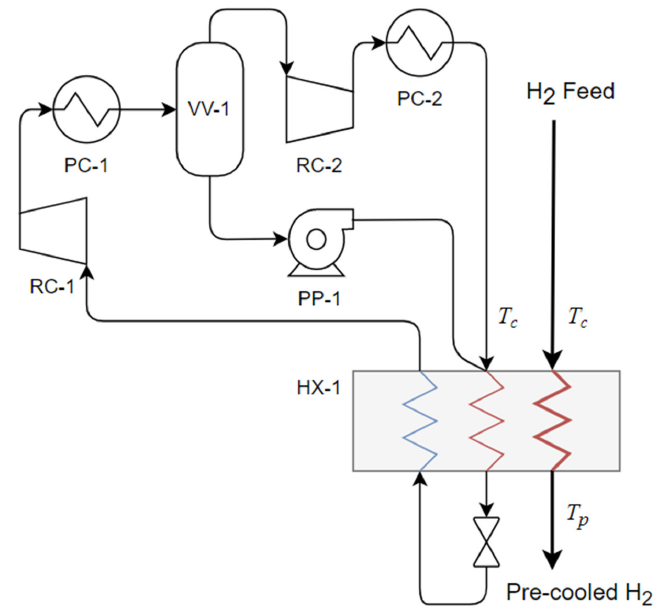
Figure 1. Flow diagram for the MR H 2 pre-cooling process.